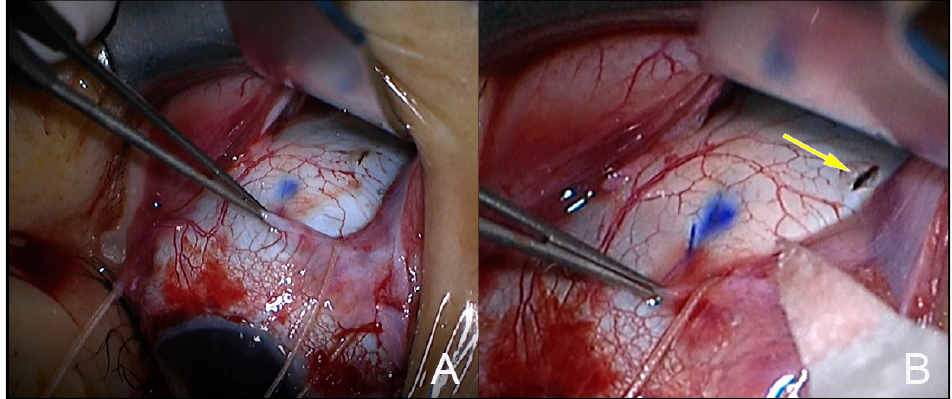
Figure 3. Intraoperative photograph of the inferonasal sclera during sclerotomy. ( A ): Scleral incision was made inferior to the internal rectus muscle to drain the subretinal fluid. Blue sclera was not observed. ( B ): Magnified image shows that the sclera at the site of sclerotomy (yellow arrow) was very thin. No choroidal hemorrhage could be seen at the sclerotomy site during the drainage. The site of the sclerotomy was sufficiently coagulated, and then the uvea was perfo-